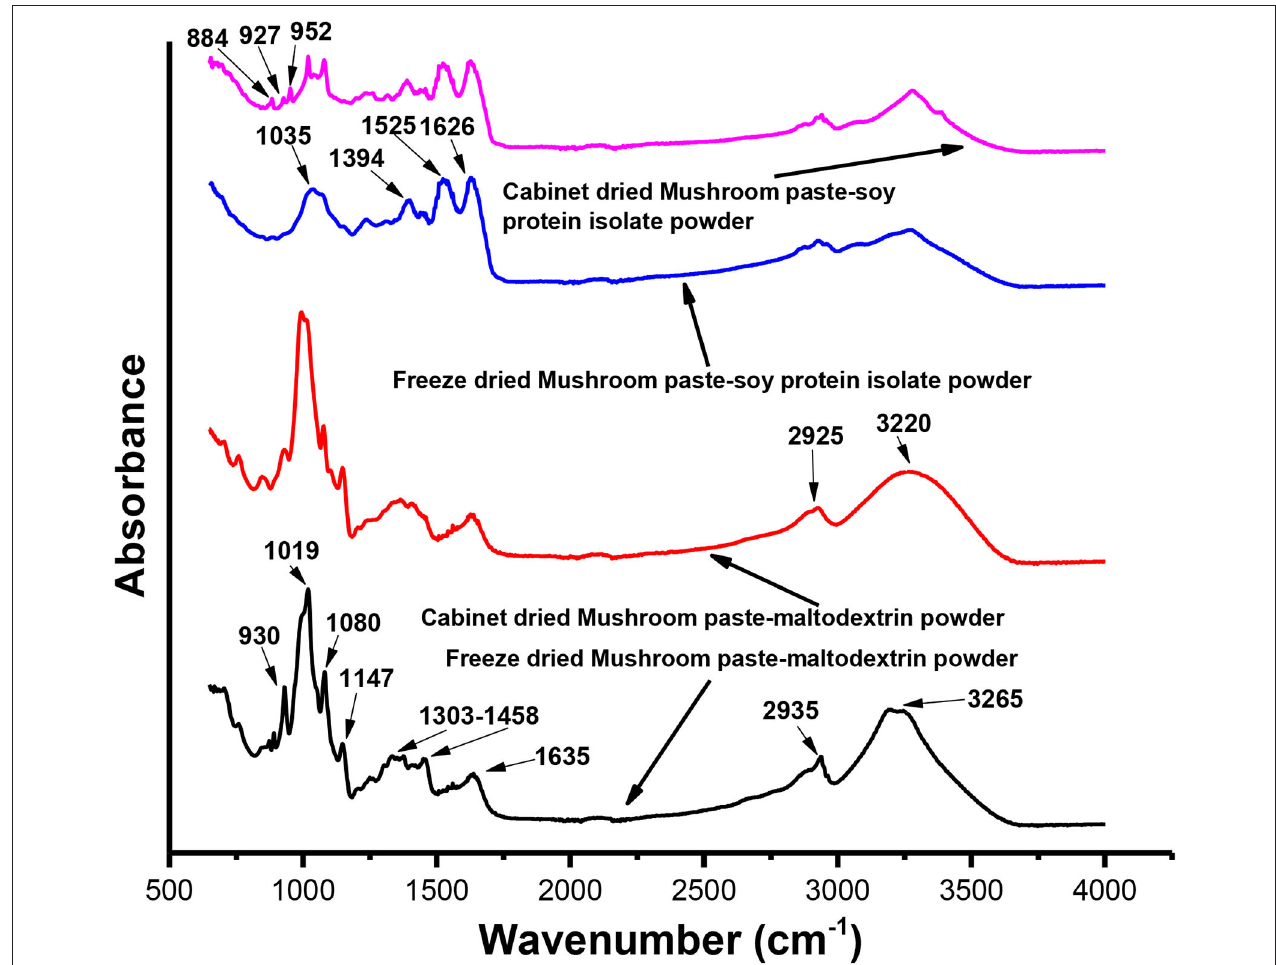
FIGURE 5 | Fourier transform infrared (FTIR) analysis of freeze-dried and cabinet dried mushroom